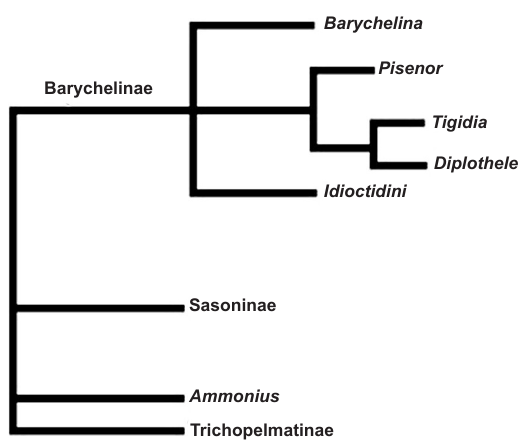
Figure 18. Cladogram showing relative position of the Pisenor, Tigidia and Diplothele in the family